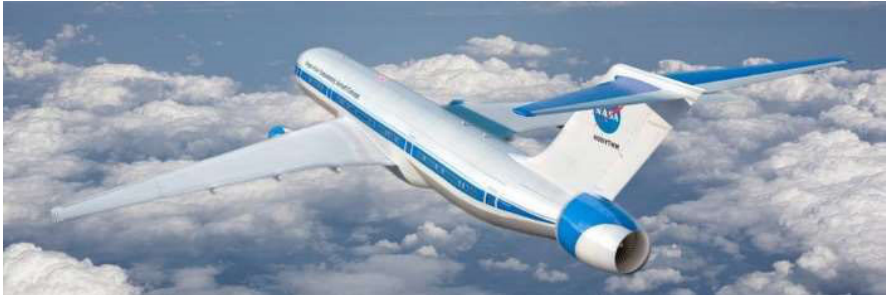
Figure 3. STARC-ABL concept